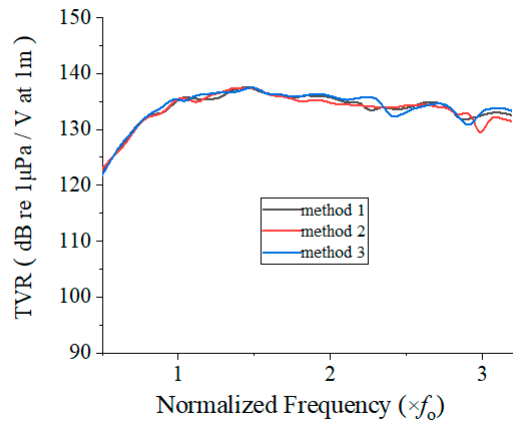
Figure 8. TVR spectra of the array potted by methods 1–3.